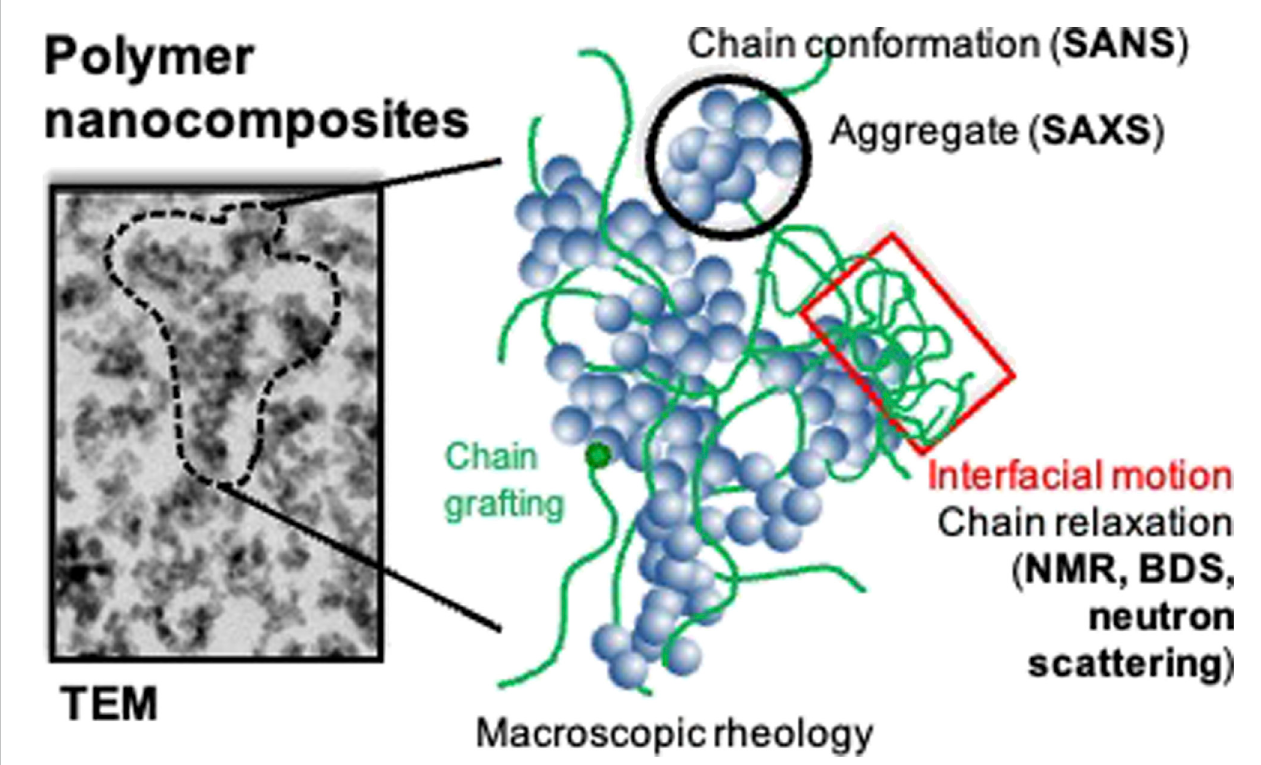
FIGURE 1 Illustration of a polymer nanocomposite with a spectrum of techniques used to characterize the structure and dynamics of nanoparticles and polymer, with a particular focus on the interfacial (possibly grafted) polymer